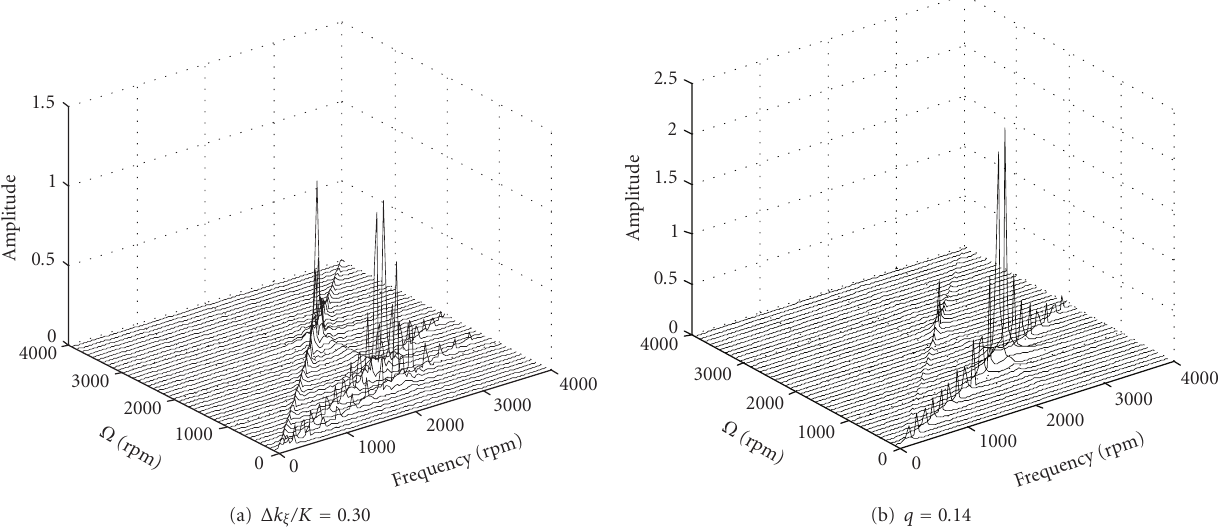
Figure 5: Half spectrum of zero-to-peak torsional vibration response, ϕ , special cases, for cracked shaft (a) and asymmetric shaft